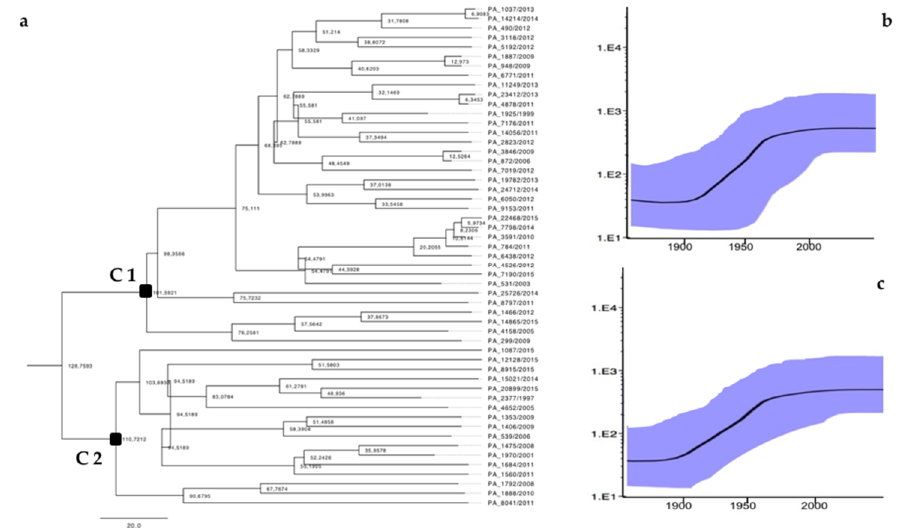
Figure 3. Bayesian maximum clade credibility tree constructed using NS3-NS5B (875 bp) concatenated sequences. The exponential growth demographic model was run for 50 million generations in BEAST 2. ( a ) Bayesian skyline plots of C1 and ( b ) C2 clusters. ( c ) The black line represents the estimated effective number of infections (y-axis) through time (x-axis). The blue shaded area corresponds to the 95% highest posterior density (95% HPD) interval.